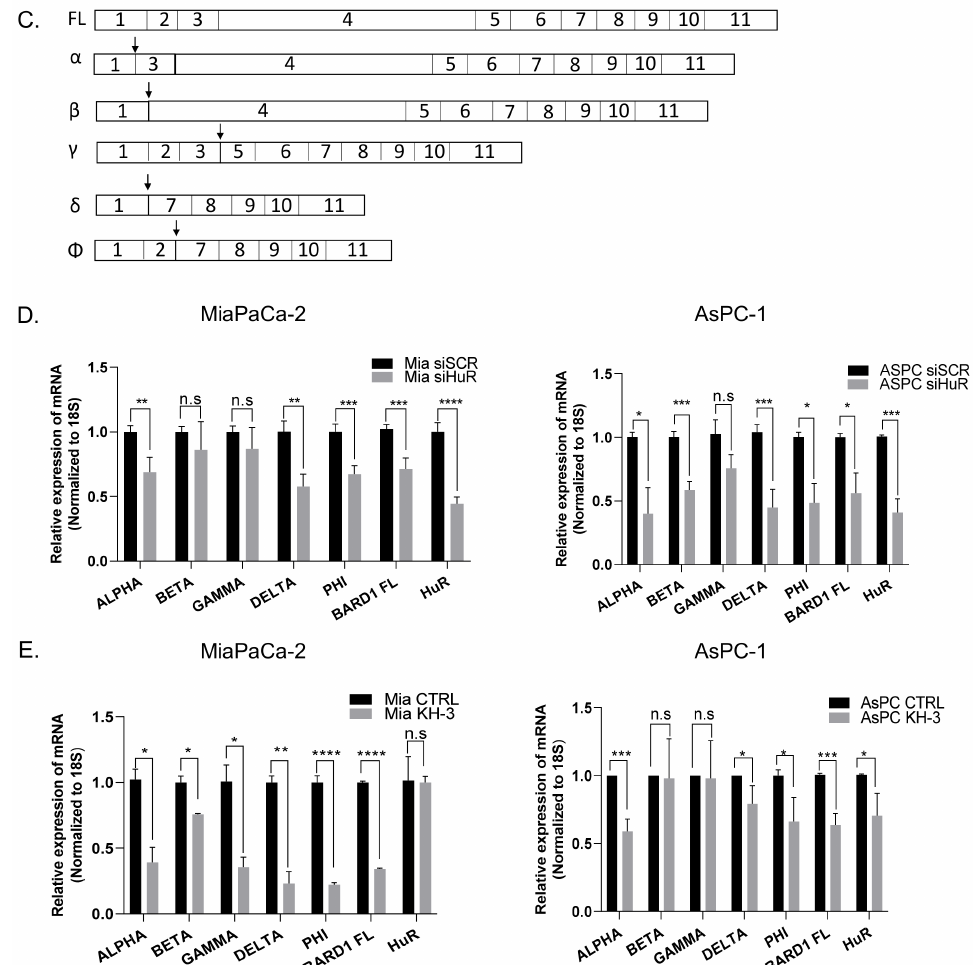
Figure 3. HuR regulates BARD1 pre-mRNA and isoform expression. ( A ) MiaPaCa-2 cells were transfected with siHuR (siHuR#1) and treated with actinomycin D (5 µ g/mL) during the indi- cated times. BARD1 mRNA stability was assayed by RT-qPCR using GAPDH as a loading control. ( B ) RT-qPCR of BARD1 pre-mRNA using three different primer sets spanning intron/exon 5, and three in cells transfected with siHuR. Mean ± SEM, n = 3. **** p < 0.0001, *** p < 0.001, ** p < 0.01. (Student’s t -test). ( C ) Pictorial representation of BARD1 isoforms. Arrows indicate location of forward primer at specific exon junctions for each isoform. Reverse primers were located in the adjacent exon. Relative mRNA expression of BARD1 isoforms in MiaPaCa-2 and ASPC-1 cells transfected with either siHuR or siSCR ( D ) or treated with KH-3 ( E ). Mean ± SEM, n = 3. **** p < 0.0001, *** p <